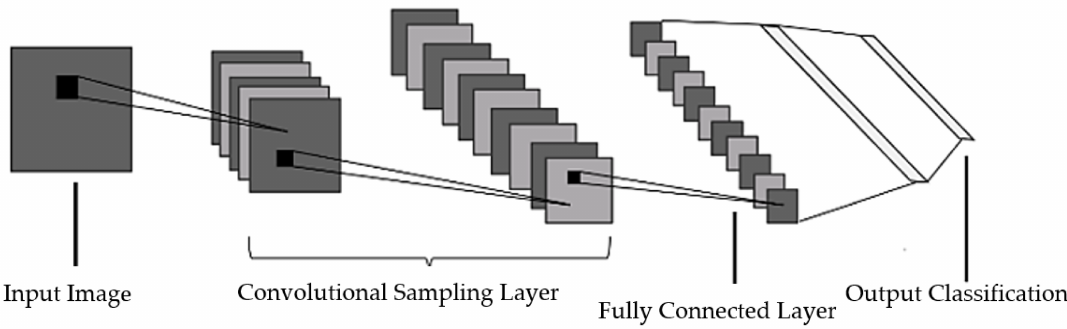
Figure 9. Classification network model structure diagram.